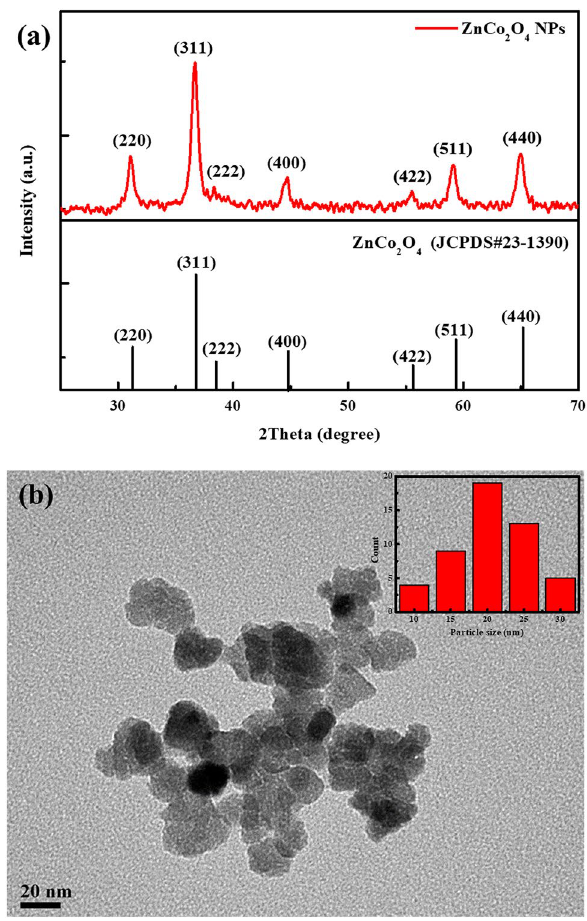
Figure 1. ( a ) XRD patterns and ( b ) TEM image of the ZnCo 2 O 4 NPs. The inset shows the size distribution of